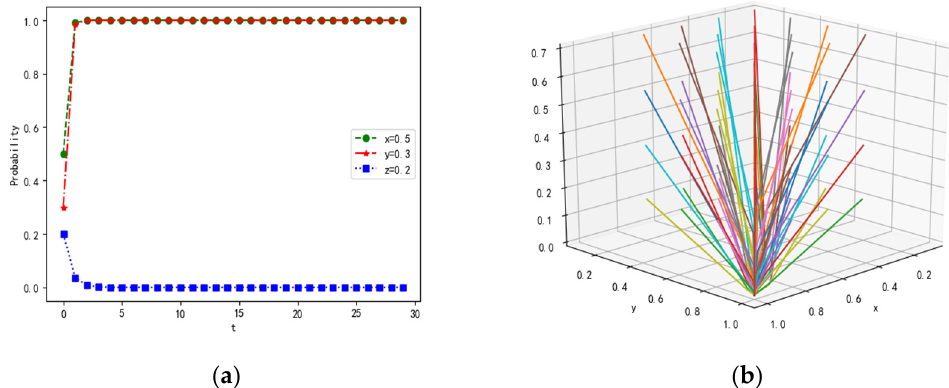
Figure 4. Evolutionary results of 𝑝 (cid:2871) (1,0,0) shown under a corresponding constraint condition, ( a ) represents the conver- 352 gence of probability with time, and ( b ) shows the results of dynamic simulation in three dimensions. Figure 5. Evolutionary results of 𝑝 (cid:2872) (1,1,0) shown under a corresponding constraint condition, ( a ) represents the conver- 354 gence of probability with time, and ( b ) shows the results of dynamic simulation in three dimensions.